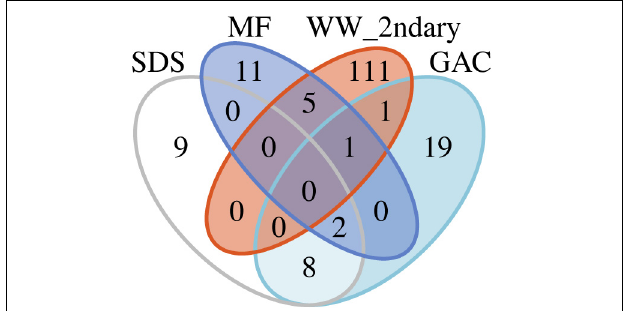
FIGURE 5 | Recurring ASVs shared between different locations in the treatment train. Counts include only ASVs that appear in at least two samples from the same location with at least 50 reads. All parallel GAC samples and all SDS samples were included together as single “locations” for this analysis. Read counts and abundances of the four ASVs shared between secondary wastewater (“WW_2ndary”) and MF can be found in Supplementary Figure S7